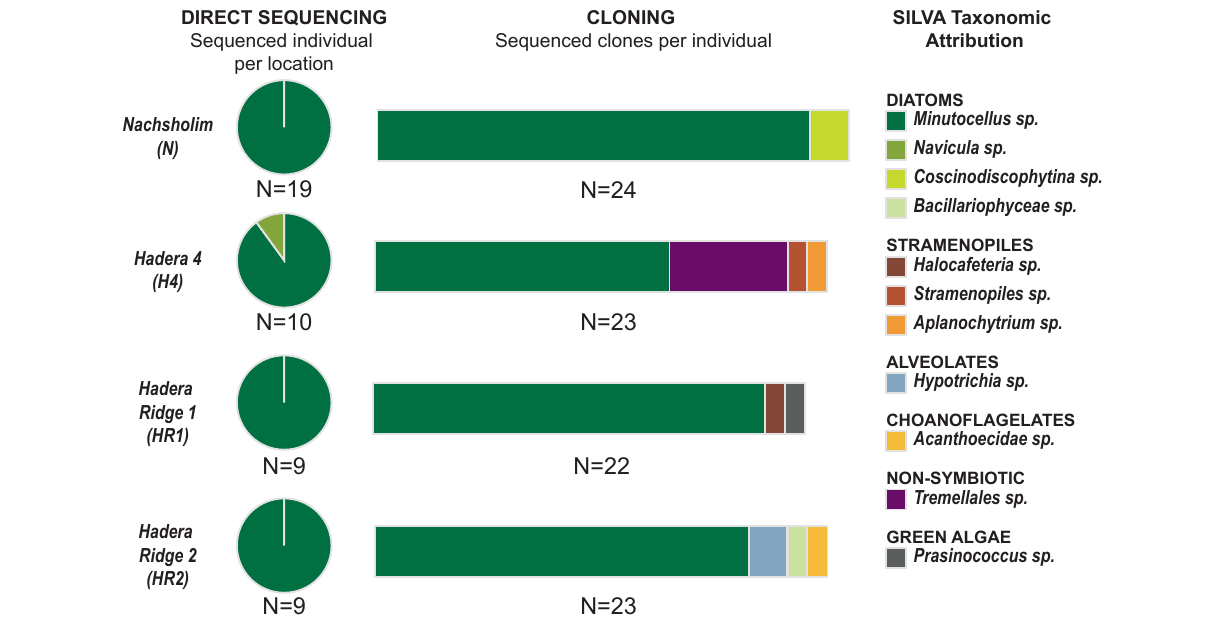
Frontiers in Microbiology |